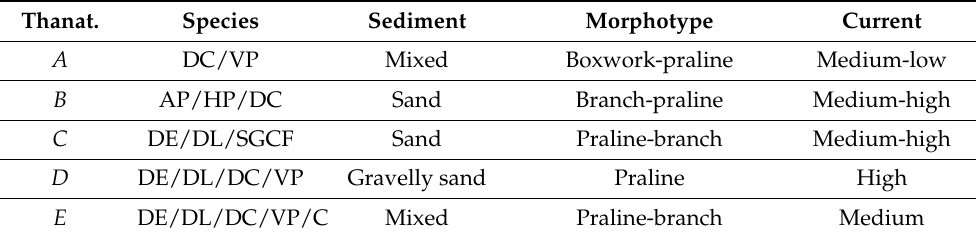
Table 2. A summary of the main features related to the identified thanatocoenoses. “Thanat.” in the first column is s for